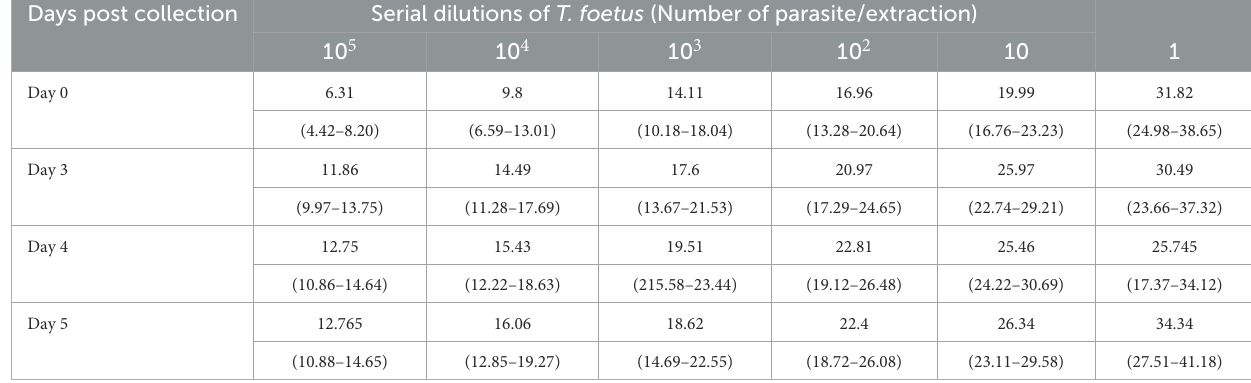
TABLE 4 Tritrichomonas foetus direct RT-qPCR is shown as mean quantification cycle (Cq) values and an estimated 95% confidence interval (in parentheses).